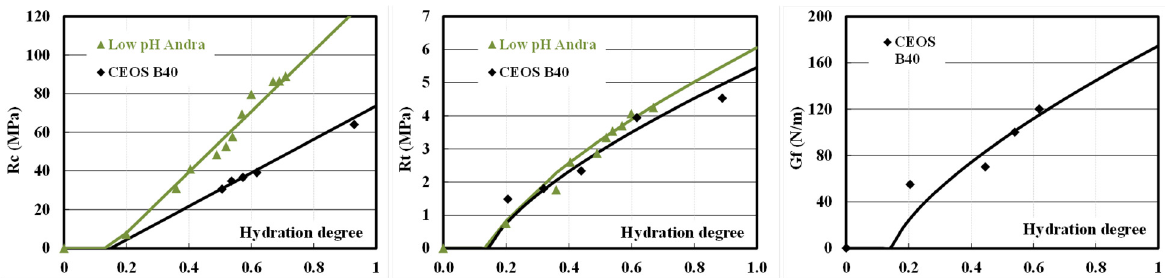
Figure 7. Evolution of strengths and fracture energy according to hydration degree for 2 concretes (Measurements from [29, 30]).